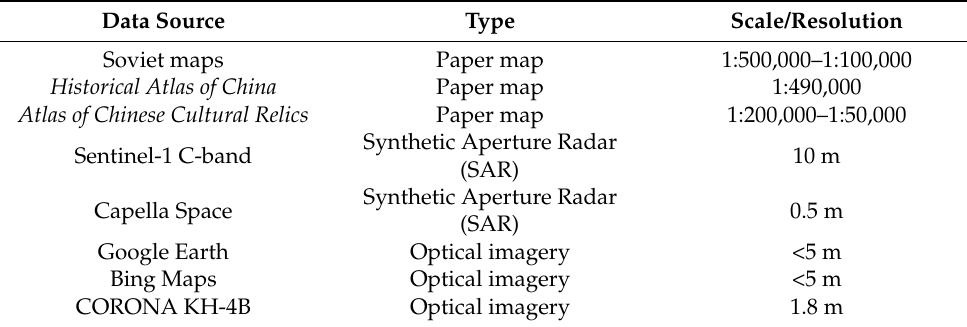
Table 1. Types of remote sensing data and maps used to locate the